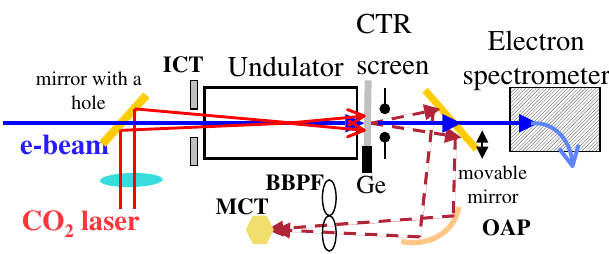
FIG. 1. (Color) A schematic of the experiment. ICT is an inte- grating current